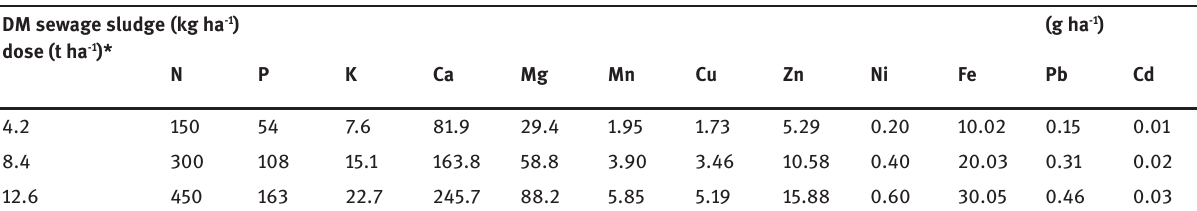
Table 2: Macro and microelements and heavy metals in a sewage sludge dose.